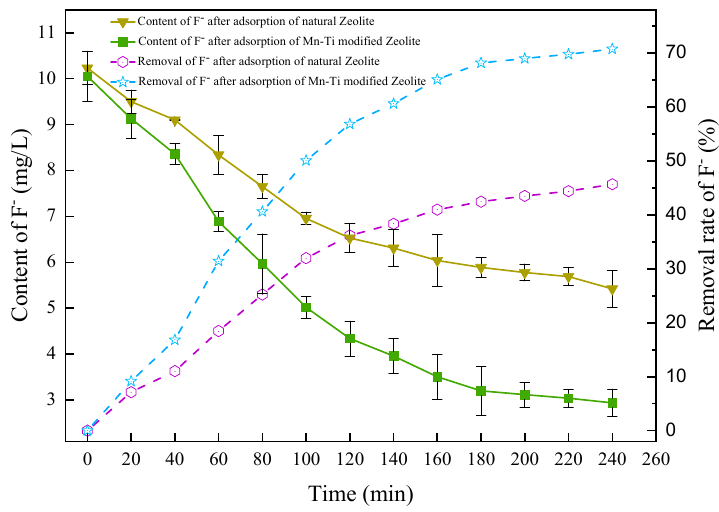
Figure 12. Removal of fluoride ions with natural and Mn-Ti modified zeolites; 2 g of zeolites were placed in the 0.25 L wastewater solution with 1 × 10 − 2 g/L initial fluoride at 25 °C.